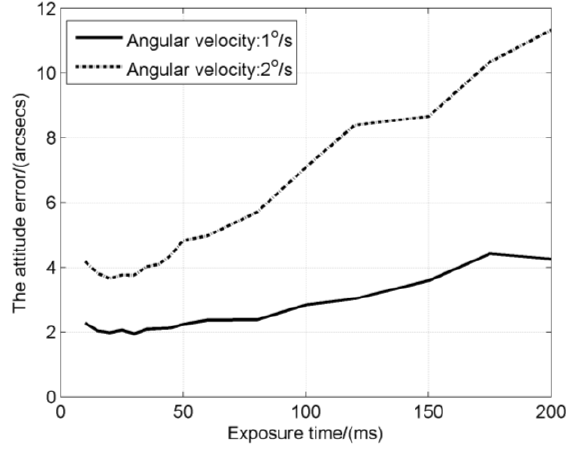
Figure 11. The attitude error with different exposure times in the